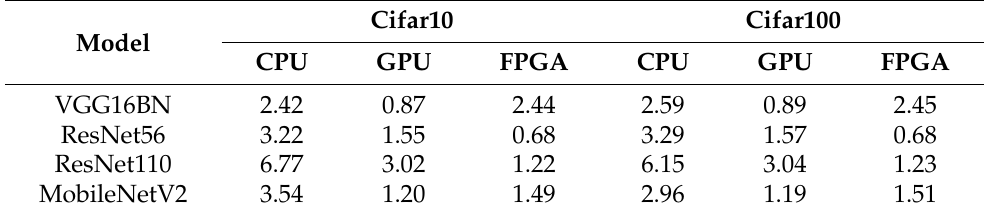
Table 5. Average inference time of the base models on the GPU and FPGA.